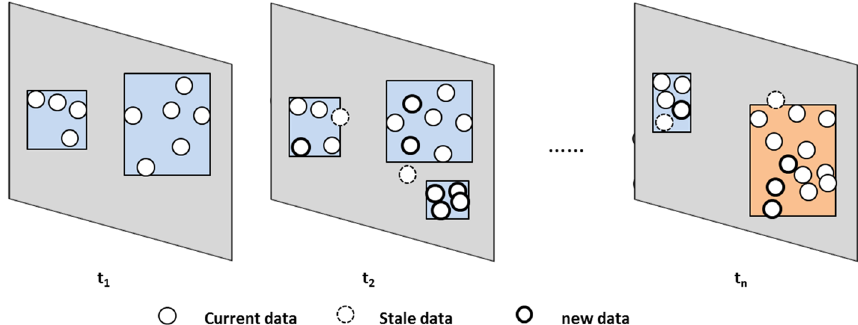
Fig. 2 Dynamic clustering on time‑decaying data stream. In the figure2 , each gray area represents data clustering result at differentinstants of time; the blue rectangle represents the cluster cell and the orangerectangle represents the dynamic cluster. And the dotted hollow, the solid hollow and the thickened solid hollow circle represent the stale, curent and newdata